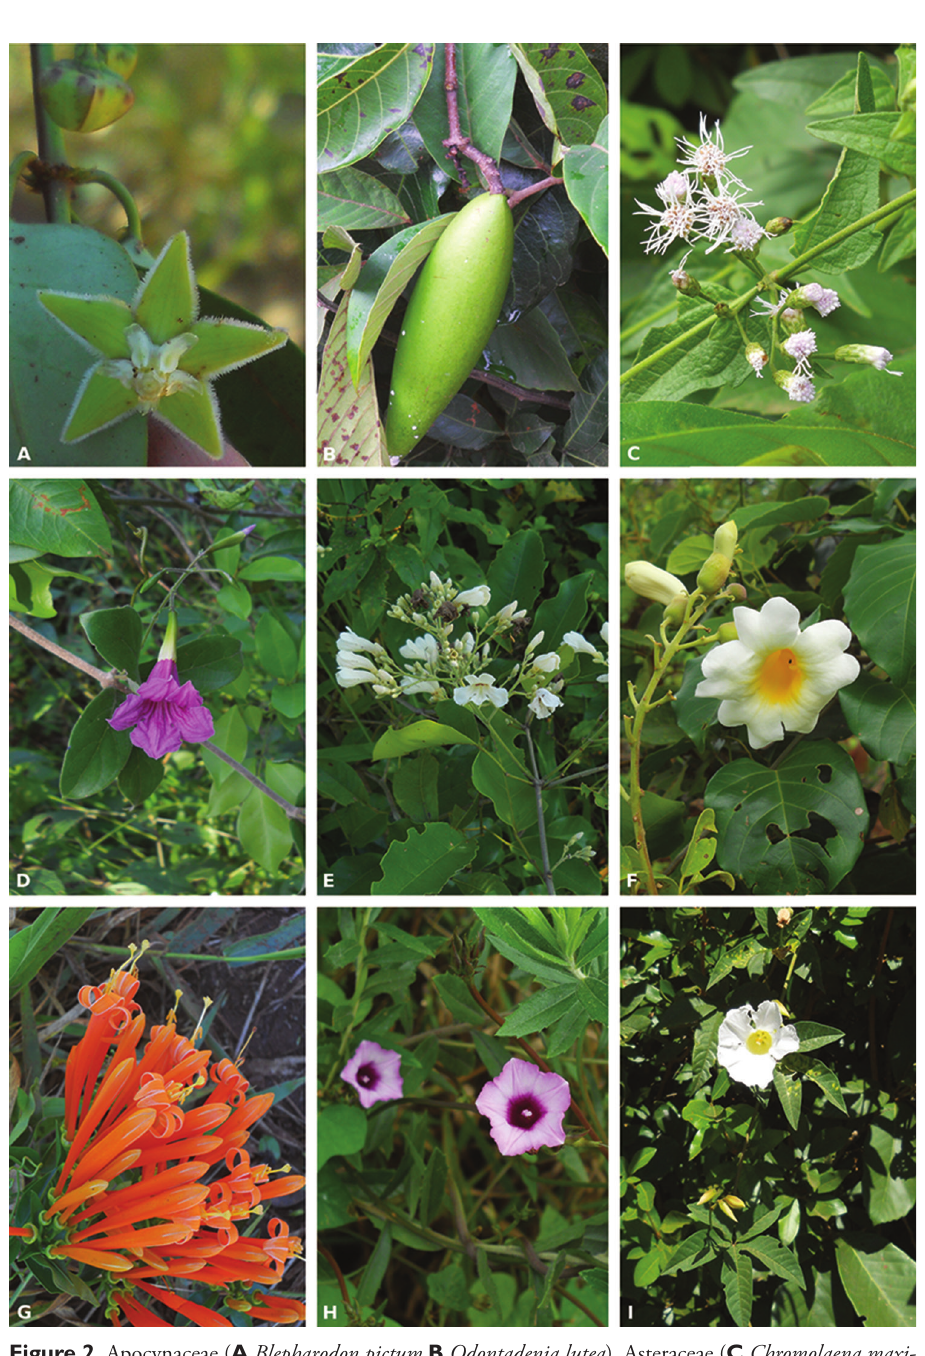
Figure 2. Apocynaceae ( A Blepharodon pictum B Odontadenia lutea ). Asteraceae ( C Chromolaena maxi- miliani ). Bignoniaceae ( D Fridericia craterophora E F. florida F Distictella mansoana G Pyrostegia venusta ). Convolvulaceae ( H Ipomoea aristolochiaefolia I Merremia macrocalyx